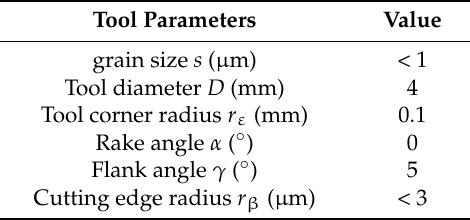
Figure 6. ( a )SEM image of the polycrystalline diamond (PCD) end mill and ( b ) measuring of cutting edge radius. Table 2. Tool parameters of the PCD corner radius end mills.